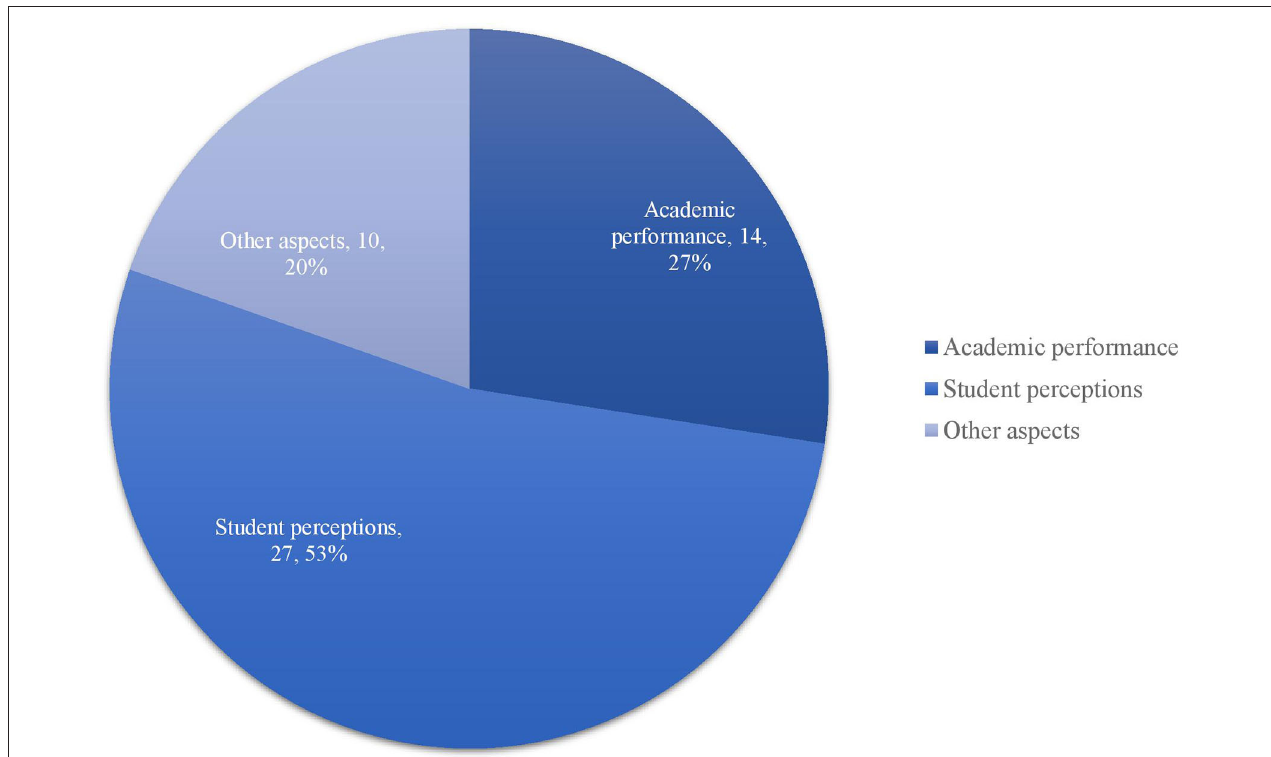
FIGURE 7 | Research foci of included